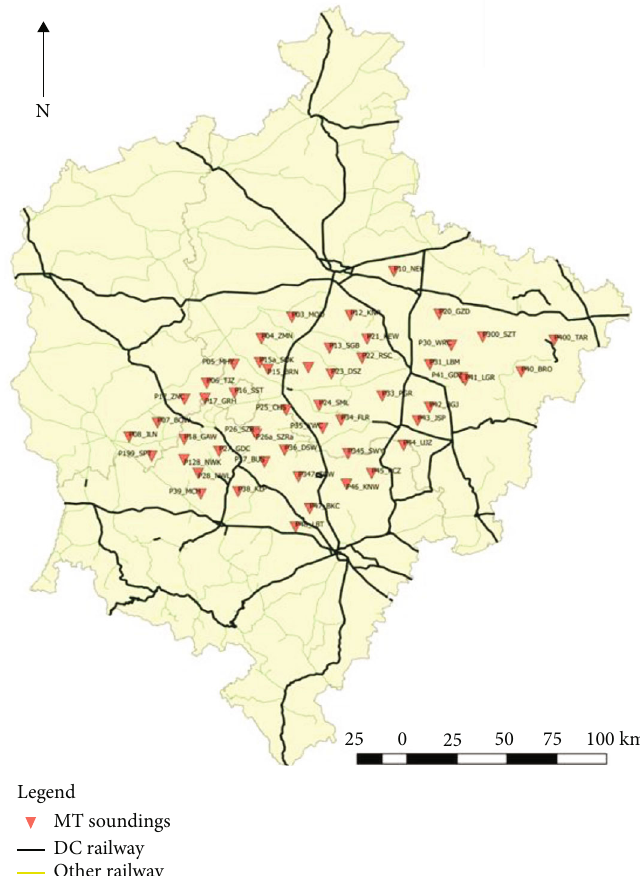
Figure 3: The measuring stations ’ location on the railway map background (the primary source of disturbances) of the area where the fi eld works were carried